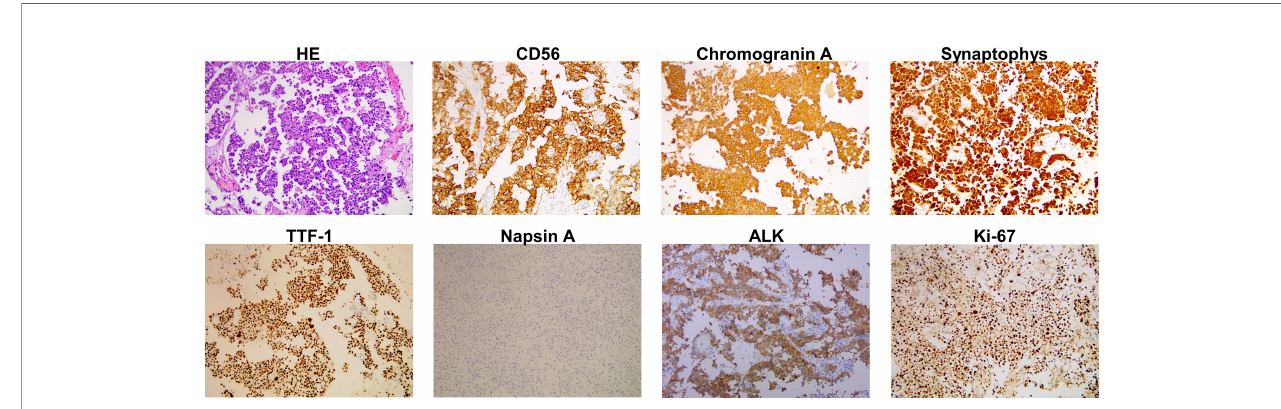
FIGURE 2 | Histopathological fi ndings of the tumor in left frontal lobe. Haematoxylin and eosin (HE) staining is shown. Immunostaining indicated positivity for CD56, chromogranin A, synaptophys, thyroid transcription factor-1 (TTF-1), ALK, and negative for napsin A. The Ki67 staining index